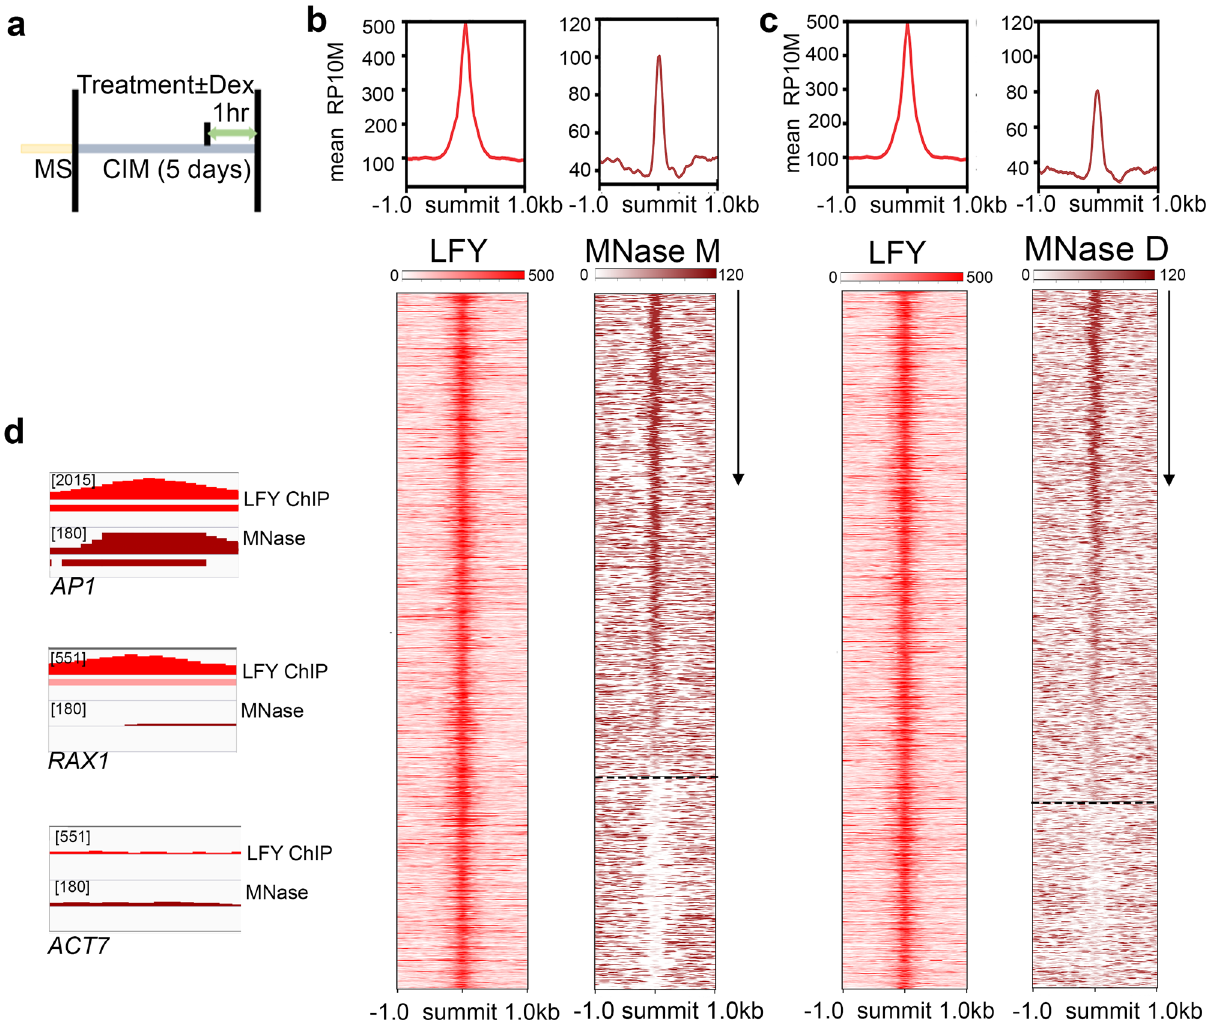
Fig. 2 LFY binds nucleosomes in vivo during root explant reprogramming. a Experimental setup to test in vivo association of LFY with nucleosomal DNA and timeline for LFY-GR treatments. MS: seedling growth medium, CIM: root explant medium. b , c Top: Mean signal of signi fi cant LFY ChIP-seq (RP10M; q value ≤ 10 − 10 , MACS2) and of nucleosome occupancy (DANPOS; q value ≤ 10 − 50 ) in root explants ± 1 kb of signi fi cant LFY peak summits. Bottom: ChIP-seq and MNase-seq signal in a 2 kb region centered on signi fi cant LFY peak summits and ranked by nucleosome occupancy levels (arrow) in the LFY peak summit region (±75 bp). Root explant treatments: LFY-GR ChIPseq: one-hour steroid treatment. MNase: low MNase digestion of one-hour mock treated LFY-GR samples (b) or low MNase digestion of one-hour steroid treated LFY-GR samples (c). Dotted lines separate nucleosome occupied (top) from nucleosome free (bottom) LFY binding sites. d Browser view of LFY ChIPseq and MNase-seq at known LFY targets ( AP1 and RAX1 ) and at the housekeeping gene ACTIN7 ( ACT7 ). Below: signi fi cant LFY ChIP-seq peak and nucleosome; color saturation proportional to the negative log 10 q value and the signal strength, respectively. See also Supplementary Figs. 2 -